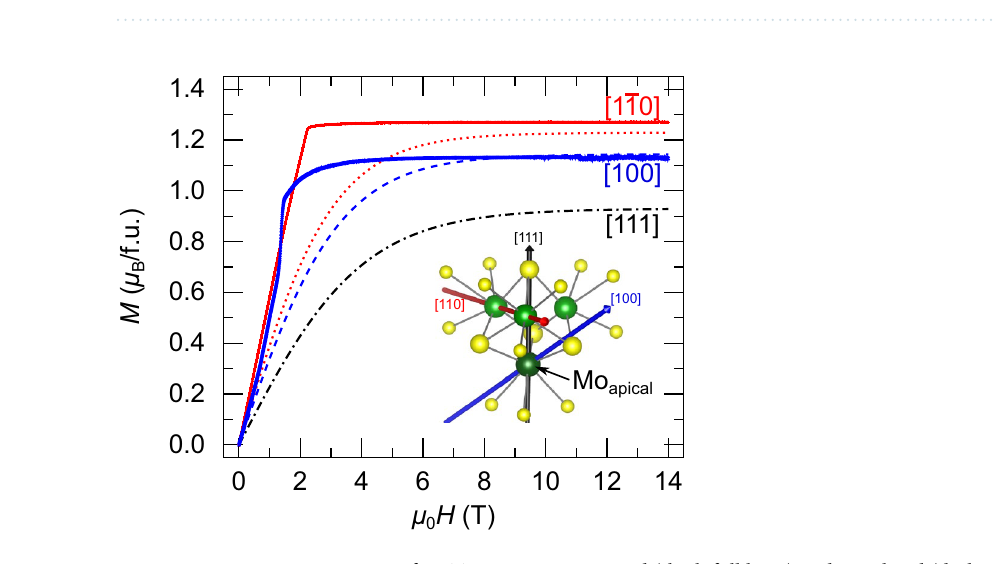
Figure 4. Magnetization curves for LT GaMo 4 S 8 . Measured (thick full lines) and simulated (dashed lines) curves were obtained at a temperature of 2.5 K. [110] (red), [100] (blue), and [111] (black) directions are given in the cubic setting. The simulated curve is obtained for a [Mo 4 S 16 ] 19- embedded cluster